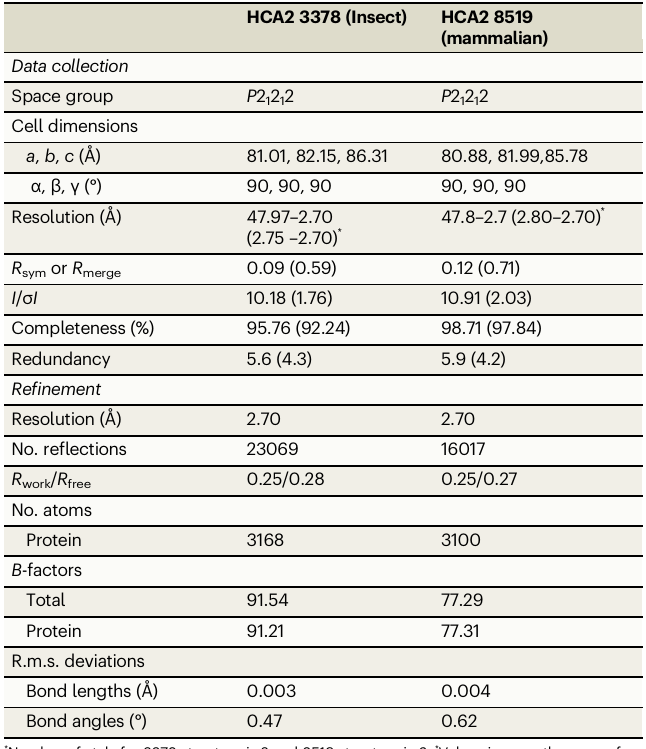
Table 1 | Cryo-EM data collection, re fi nement and validation statistics of HCA2-G i complex